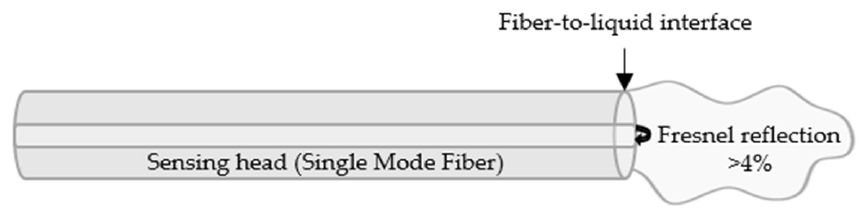
Figure 2. Scheme of the sensing head operating mechanism.